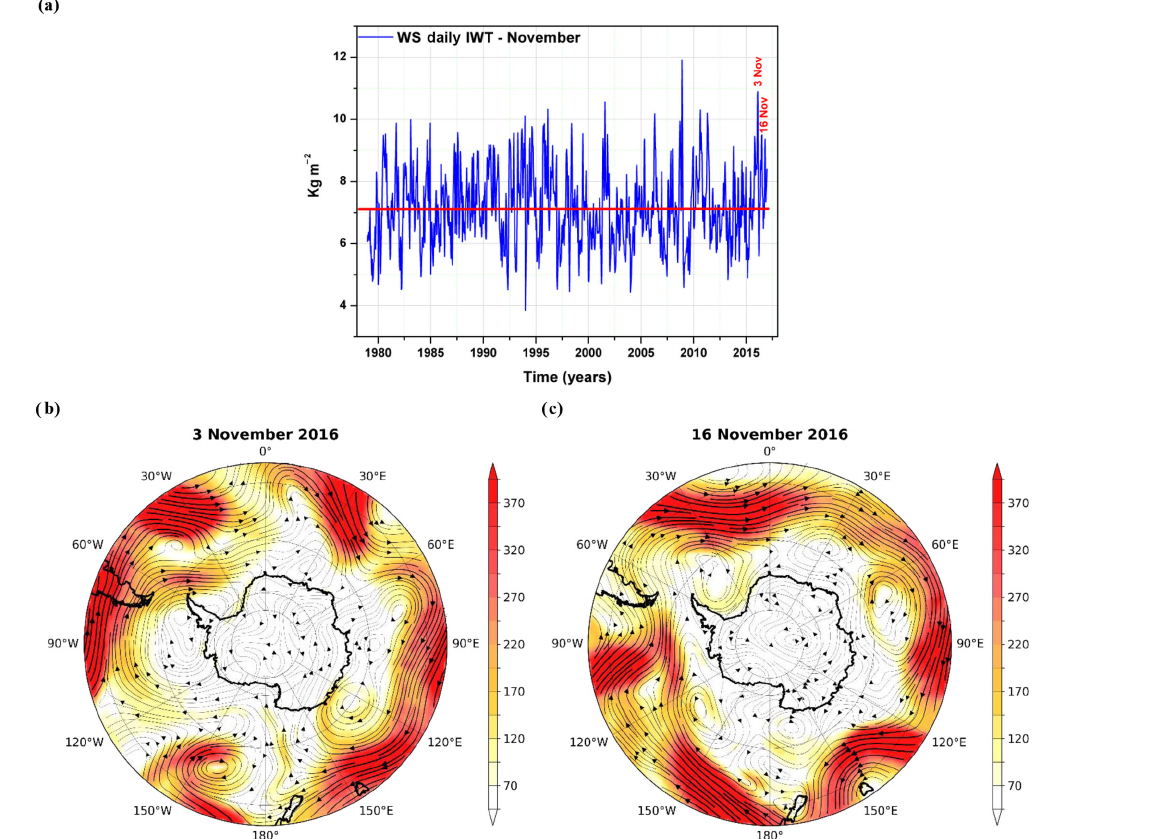
Figure 10. (a) Daily IWT averaged over the WS (black square in Fig. 4h) over the period 1979–2016; (b) the vertically integrated water vapor transport (WVT) on 3 November 2016 and (c) as in (b) but for 16 November 2016. In (b) and (c) the color-shaded areas indicated the magnitude of the moisture transport and the vectors the direction of the moisture transport.